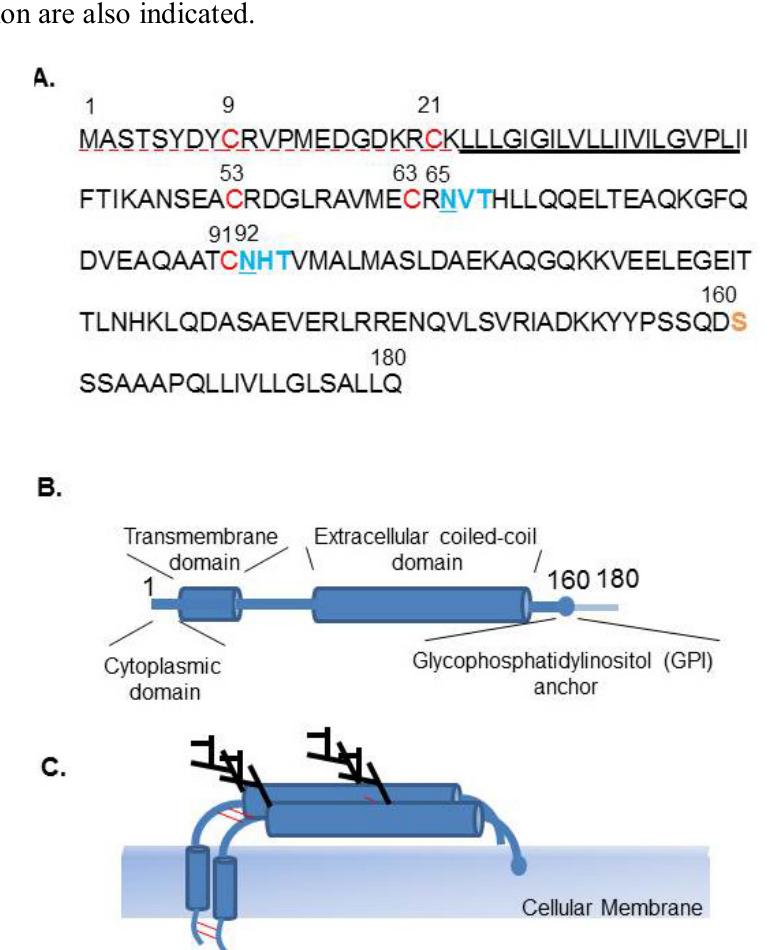
Figure 7. Characteristics of human Tetherin. ( A ) Amino acid sequence of human Tetherin (accession number NP_004326). Dashed red underline (1-22) indicates the cytoplasmic domain (CD), underline indicates the transmembrane domain (TM). Red font (C9, C21, C53, C63, and C91) indicates amino acids that may be responsible for disulfide bond formation and dimerization. Blue font indicates potential N-linked glycosylation motif (N-X-S/T) and site (underlined). Serine (S) at position 160 is indicated as the site of cleavage prior to the C-terminal addition of a GPI anchor in yellow font. ( B ) Schematic representation of the domain structure of Tetherin, a type II transmembrane protein. ( C ) Tetherin forms a homodimer, through a C-C disulfide bond. Two sites of N-glycosilation are also